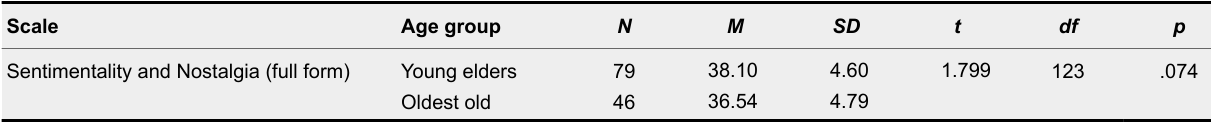
Differences in Sentimentality and Nostalgia Between Two Age Groups in Greece Scale Age group N Sentimentality and Nostalgia (full